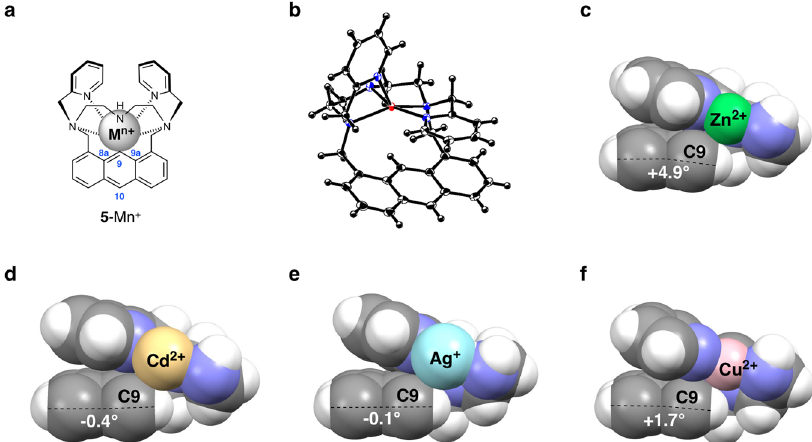
Fig. 5 X-ray structures of the metal ion complexes of probe 5. a General structure of the metal ion complex 5 -M n + . b ORTEP diagram (50% probability ellipsoids) of 5 -Zn 2 + (C 32 H 32 N 4 O 8 Cl 2 Zn). The perchlorate anions are omitted for clarity. c – f Cross-sectional views of the metal ion complexes of 5 -M n + (M n + = Zn 2 + , Cd 2 + , Ag + , or Cu 2 + ). The angle shown in each complex is the dihedral angle of C10-C9a-C8a-C9.